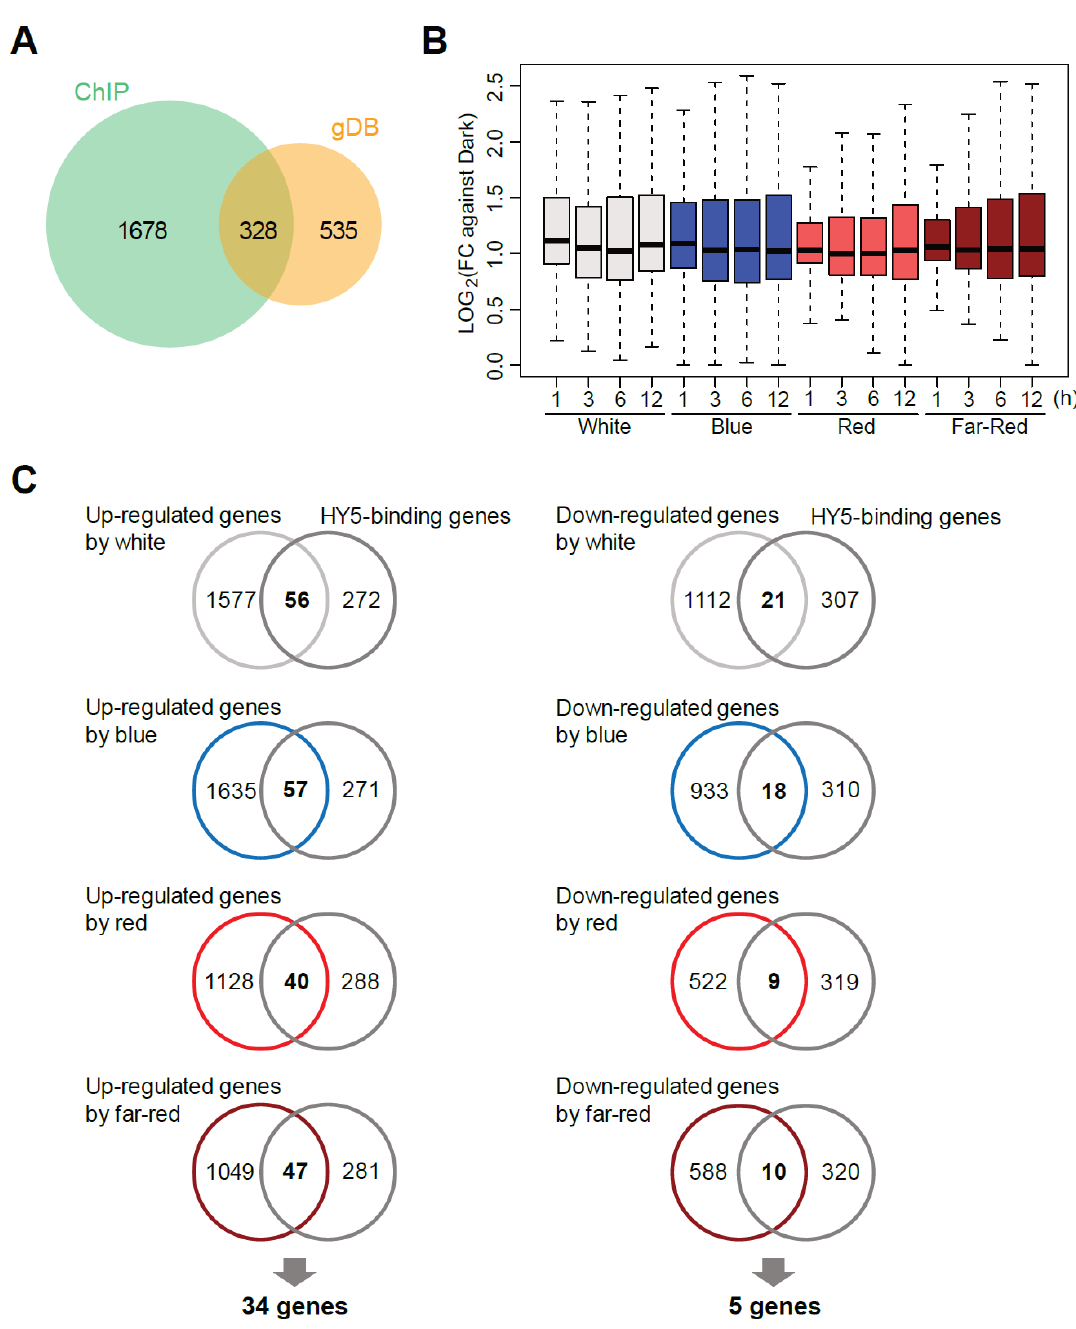
Figure 3. Relationship between ELONGATED HYPOCOTYL 5 (HY5)-binding genes and DEGs upon light exposure. ( A ) Overlap of the genes with HY5-binding sites in the promoters, which were identified by two methodologies, ChIP-seq and gDB-seq. ( B ) Boxplot of fold changes (light / dark) of the 328 HY5-binding genes which overlapped in ( A ). ( C ) Overlap between up-regulated or down-regulated genes and the 328 HY5-binding genes.